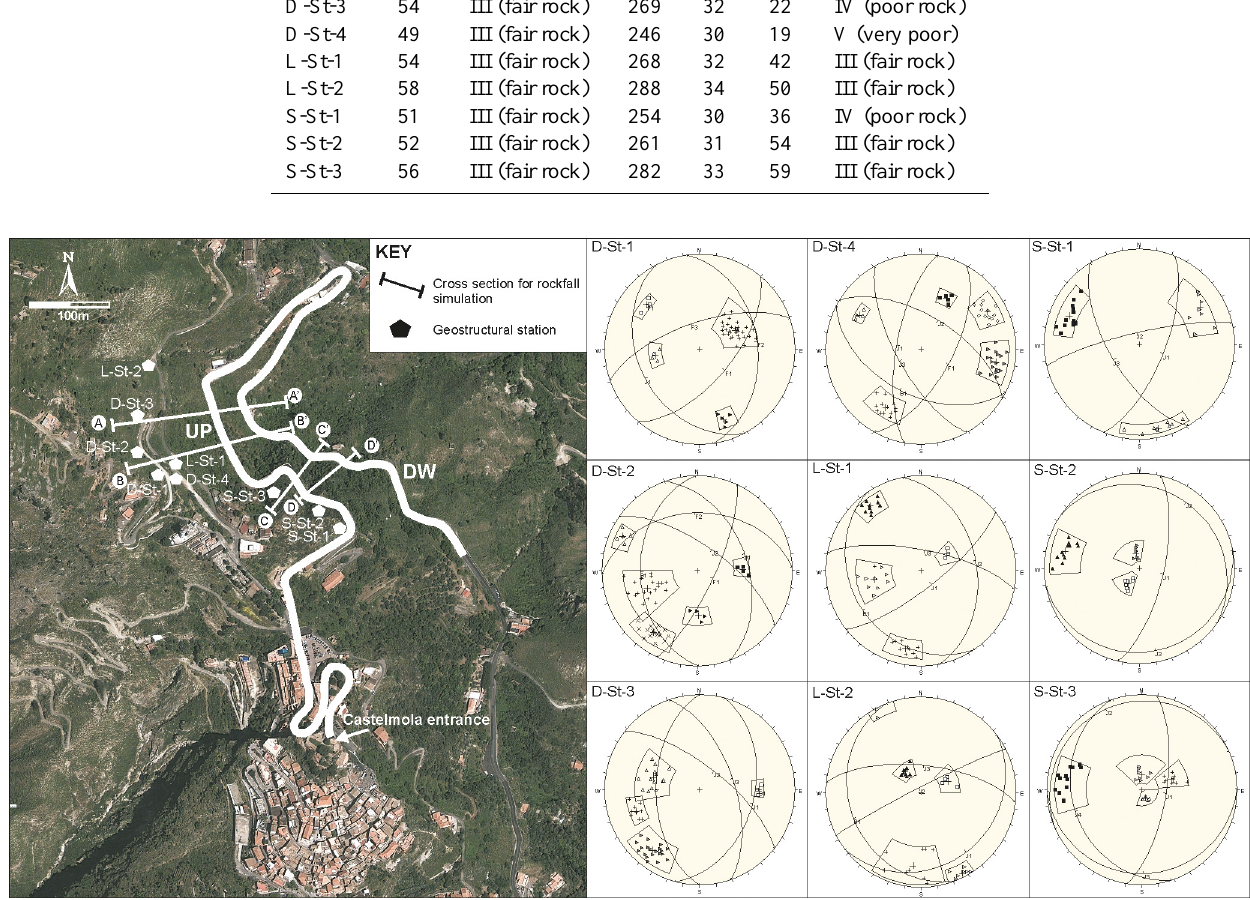
Figure 5. Cross sections for rockfall simulation and location of geostructural survey stations with resulting stereonets.